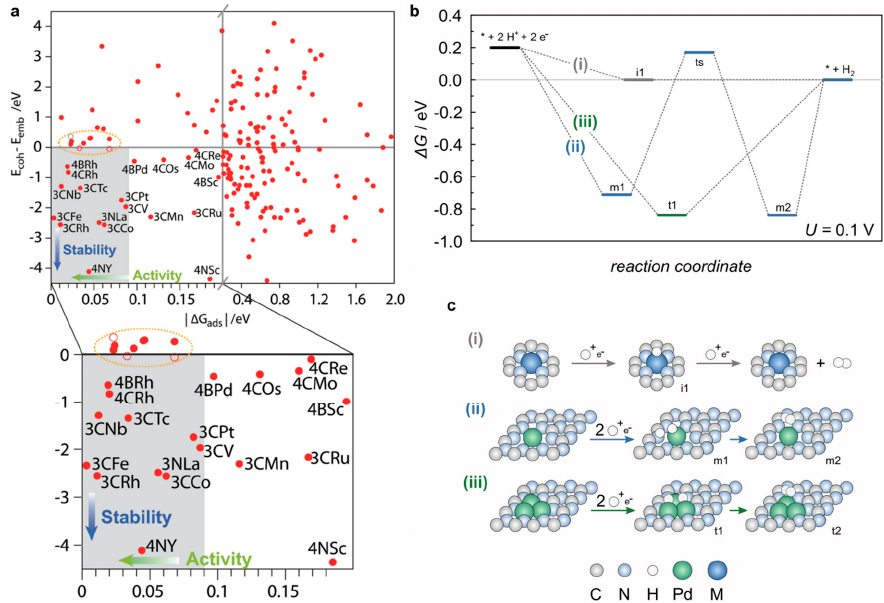
Figure 8. ( a ) Descriptor-based screening results of transition metal embedded graphene (TMEG) catalyst candidates based on activity (| Δ G ads |) and stability ( E coh – E emb ). The lower-left quadrant of ( a ) contains materials that passed both criteria. For comparison, the gray shaded region covers the range of | Δ G ads | that a Pt (111) surface could have depending on the coverage of hydrogen. Note the different scales in the left and right sides of the horizontal axis. Adapted from Reference [196], copyright (2015), with permission from John Wiley & Sons. ( b,c ) influence of active site nuclearity of single Pd atoms (ii) and Pd trimmers (iii) in the thermal part of HER versus an idealized single atom active site (i). (Values for (ii) and (iii) are originally computed as hydrogen activation and taken from reference [189].